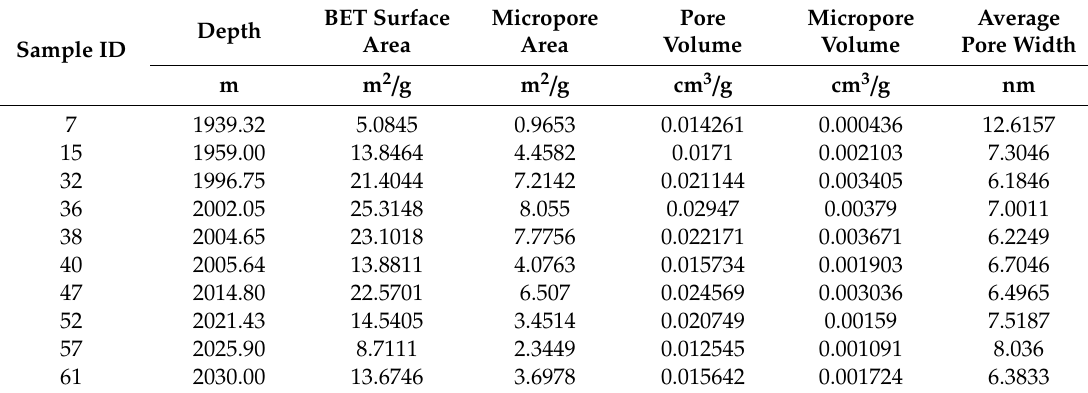
Table 6. Pore structure parameters for shale samples. BET—Brunauer–Emmett–Teller.